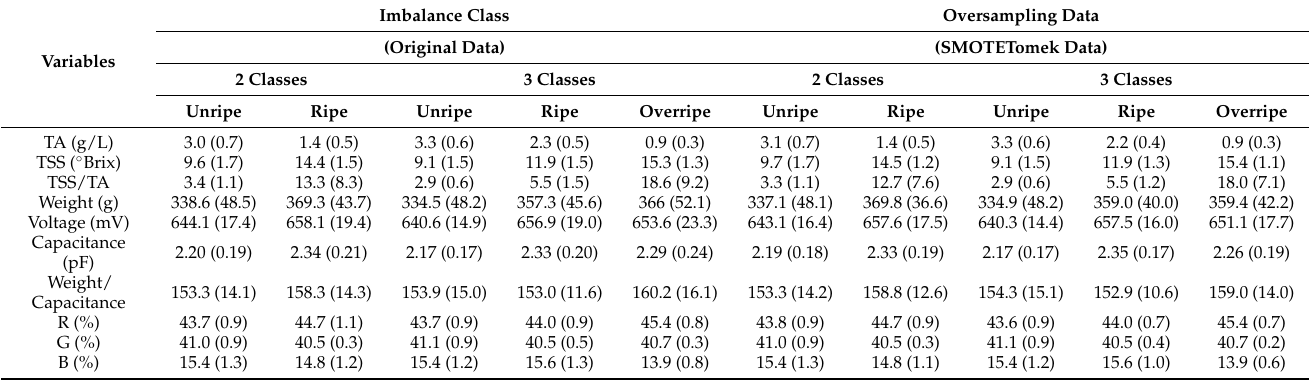
ML models for three-class classification using original data. For three-class classification, the average accuracies of the GNB, SVM, and FANN classifiers were 57.0%, 55.0%, and 79.0%,